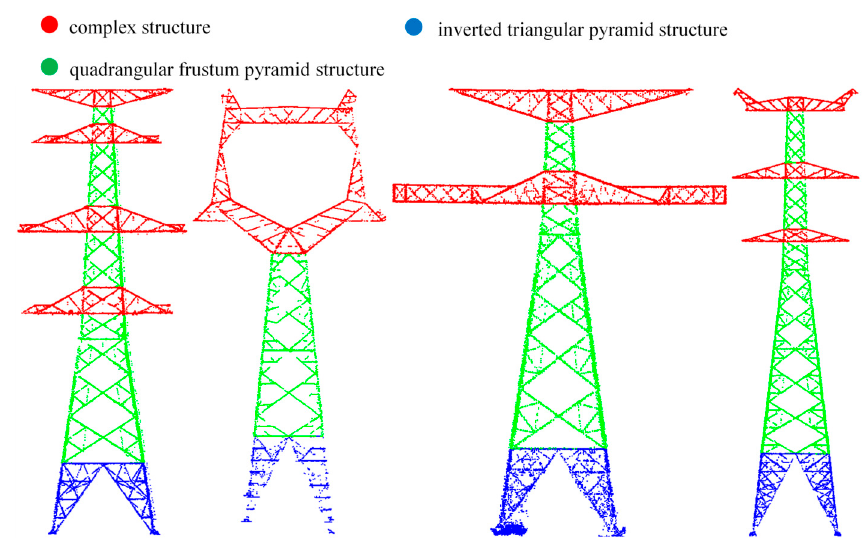
Figure 13. The results of pylons decomposition.